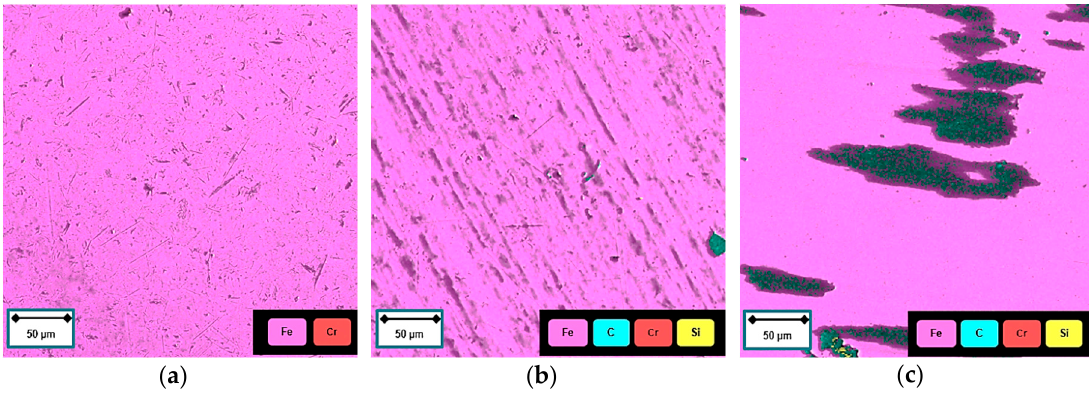
Figure 11. EDX mapping of the 100Cr6 counterpart ( a ) before tribotest; ( b ) after tribotest on 1.5 phr coated specimen; and ( c ) after tribotest on 9 phr coated specimen.